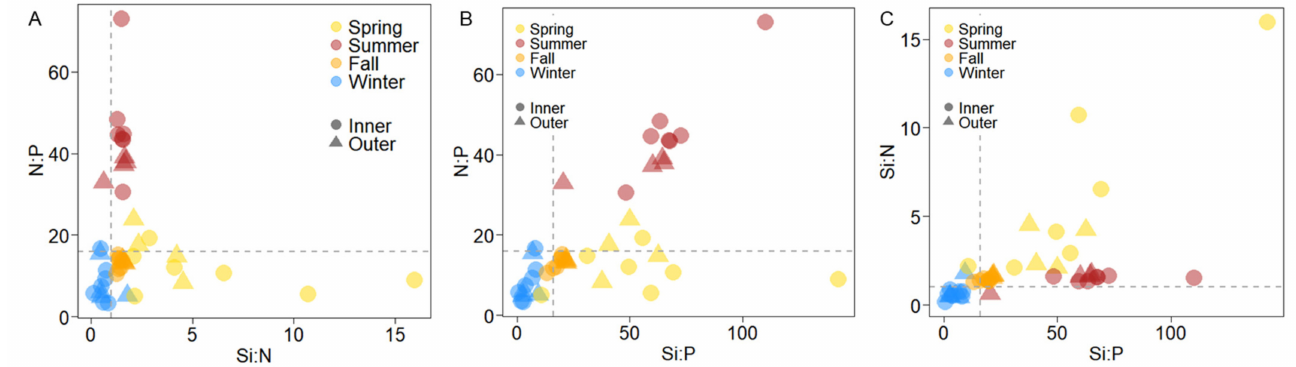
Figure 4. Redfield ratios showing the true nutrient limitations. ( A ) N-limitation via a combination of the Si:N and N:P ratios, ( B ) P-limitation via a combination of the Si:P and N:P ratios, and ( C ) Si-limitation via a combination of the Si:P and Si:N ratios.